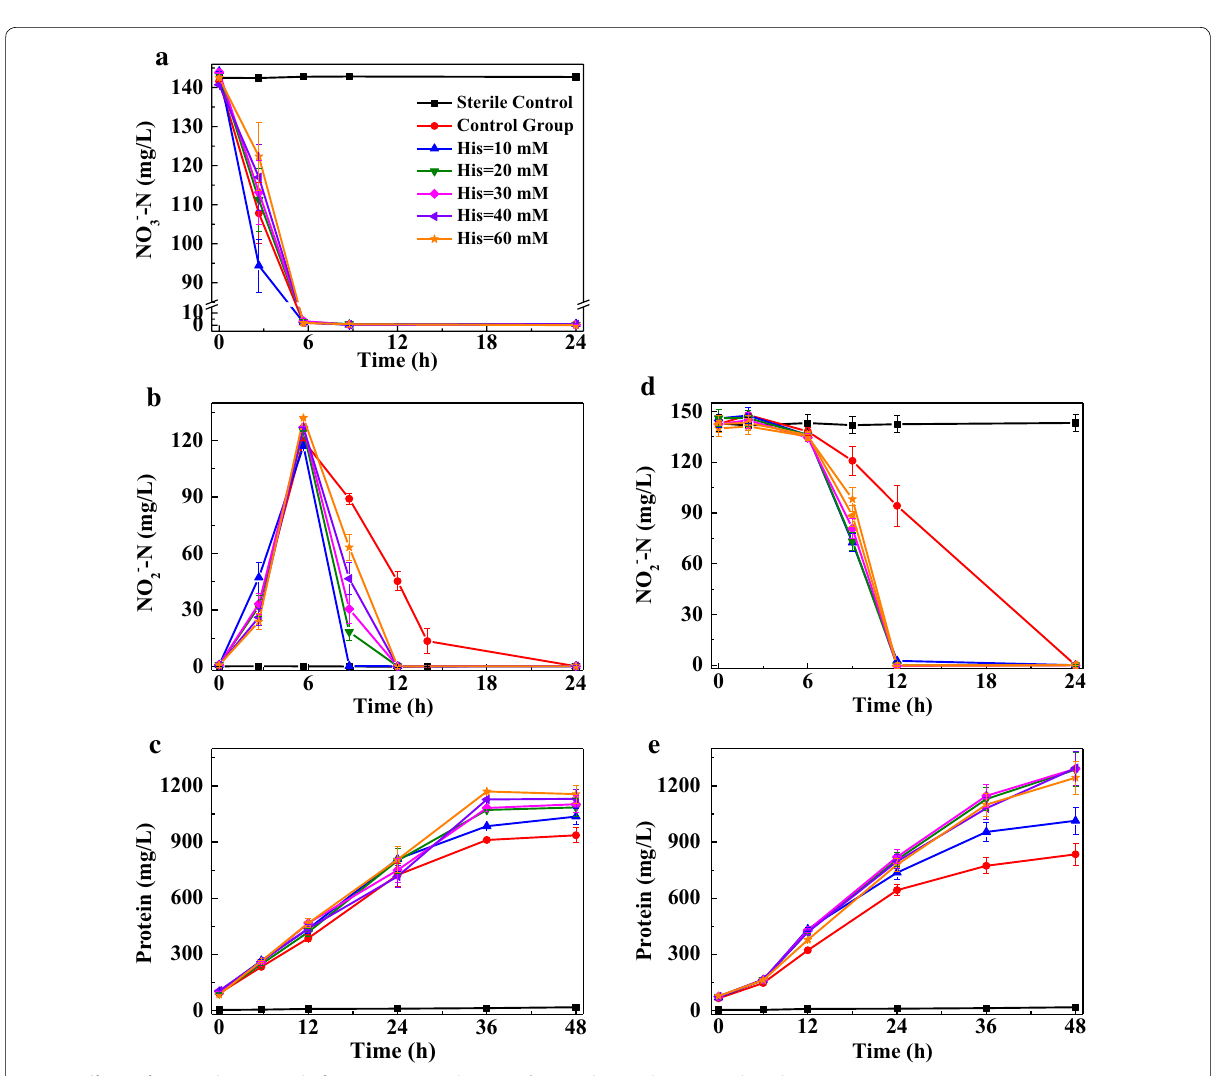
Fig. 1 Effects of His on the removal of nitrate ( a – c ) and nitrite ( d – e ) under aerobic atmosphere by strain